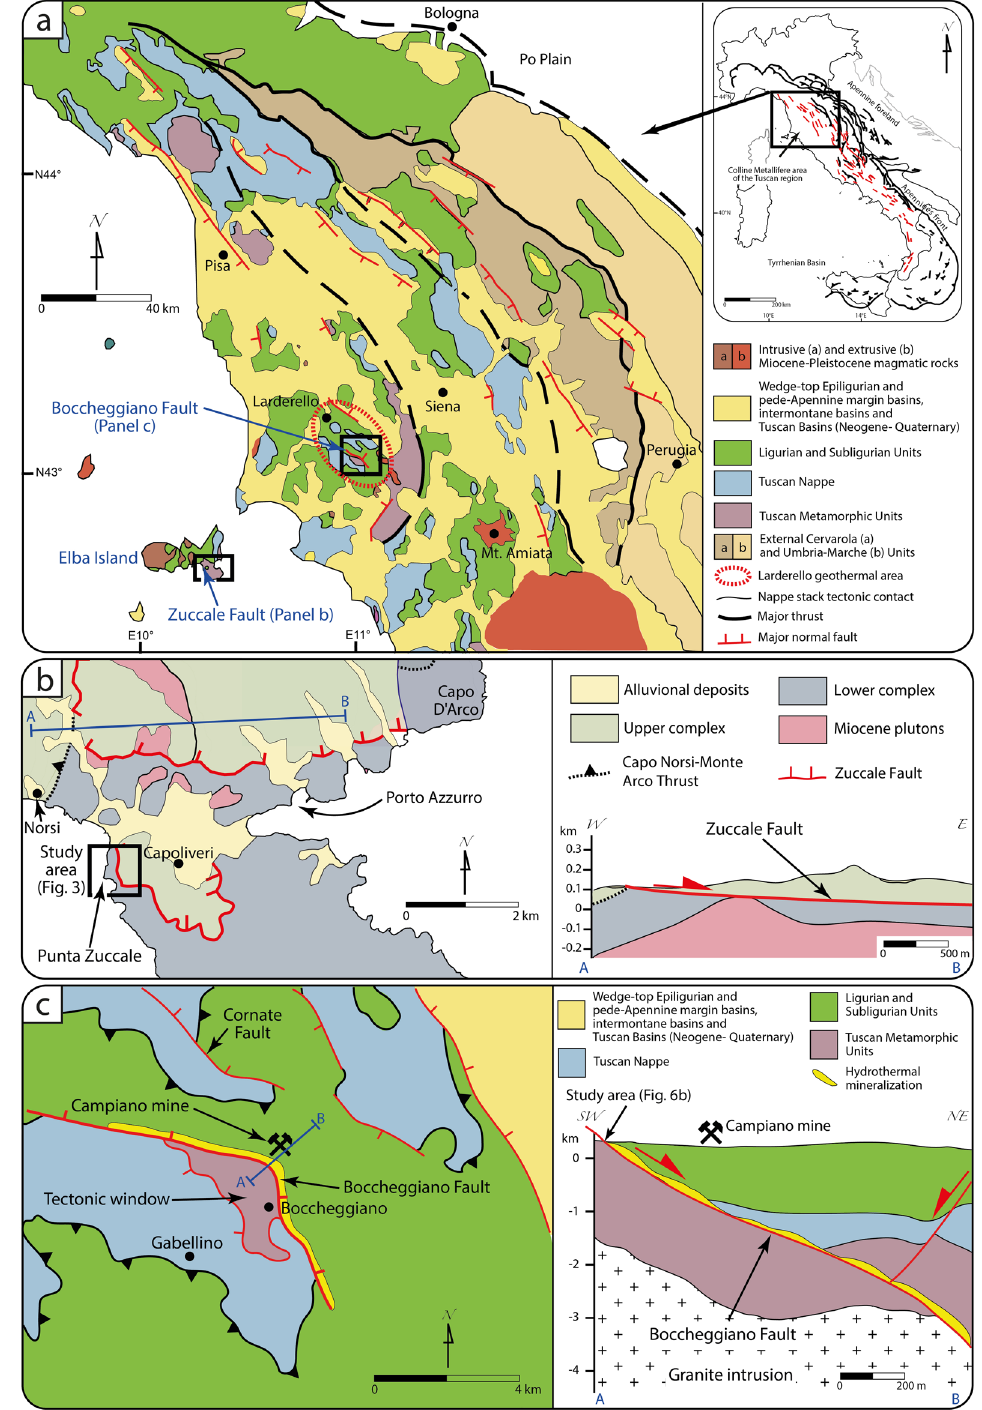
Figure 2. ( a ) Simplified geological map of the Northern Apennines (Italy) showing the tectonic units, the main thrusts and normal faults, and the location of the Zuccale and Boccheggiano faults. Redrawn and modified from 35 . ( b ) Simplified geological map of the study area (Punta Zuccale, Elba Island), where the Zuccale Fault is exposed. A cross section along the Zuccale Fault (modified and redrawn from 33 ) is also shown. ( c ) Simplified geological map and cross section of the Boccheggiano Fault (redrawn and modified from 37 ). This figure has been edited with Adobe Illustrator 2022 (https:// www. adobe. com/ produ cts/ illus trator.